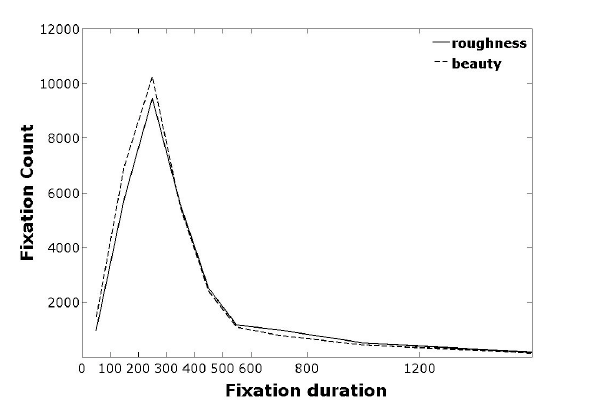
Figure 2. Distribution of fixation durations for the beauty and roughness judgments, integrated over all participants.